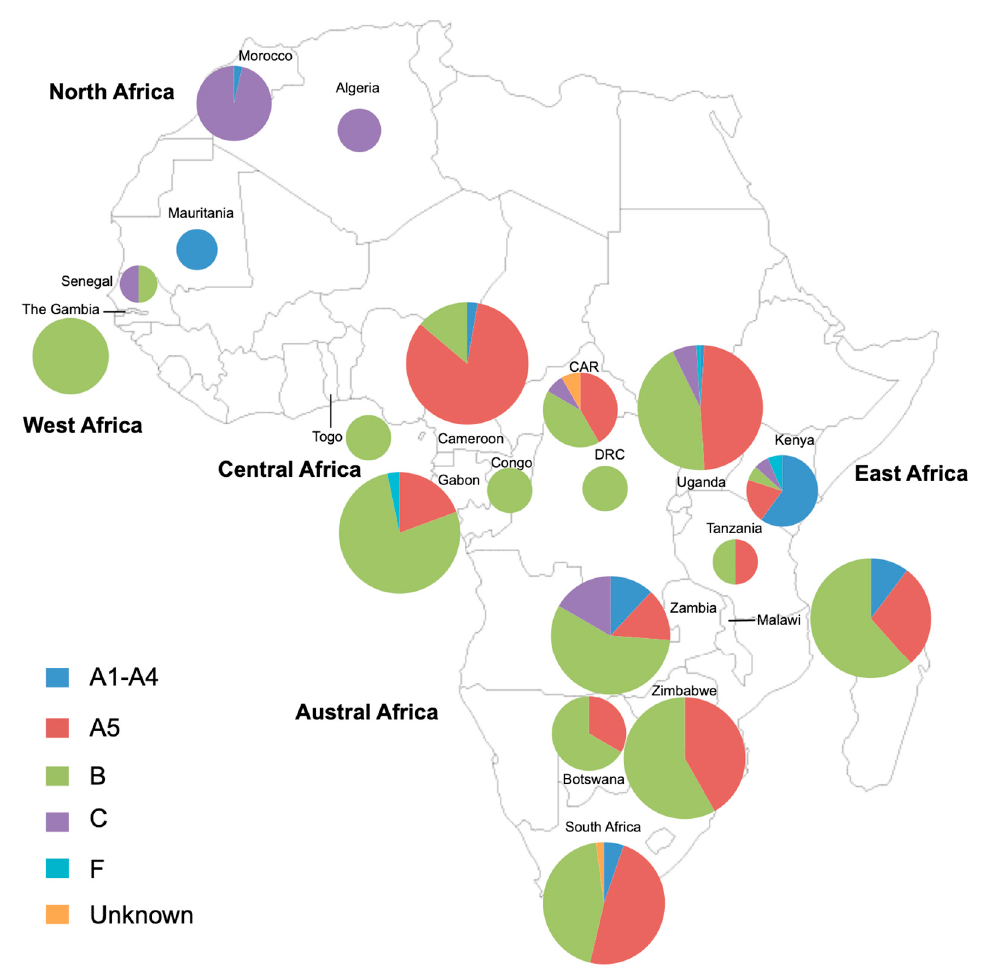
Figure 3. Map of Africa indicating the distribution of HHV-8 genotypes.